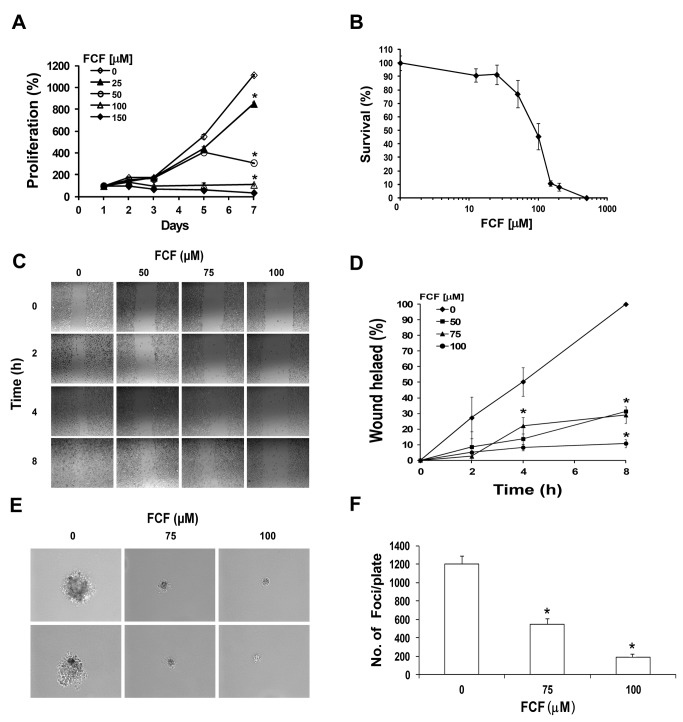
FCF inhibits cell proliferation, migration and transformation.(A) PC-3 cells were treated with increasing concentrations of FCF and grown under normoxic conditions. Cells were analyzed for proliferation at the indicated times using XTT assay. Proliferation was expressed as increase in percentage of the initial absorbance that was measured 24 h after seeding (100%). Growth media and treatment were changed every other day. Points, mean (n=3 replicates); bars, SD; *P < 0.001. This is a representative experiment out of 3 independent repetitions. (B) PC-3 cells were treated with FCF and grown under normoxic conditions for 72 h and processed for SRB cytotoxicity assay. Cell survival was expressed as percentage of the initial absorbance measured in vehicle (0.08% DMSO) control cells (100%). Points, means (n=3); bars, SD. (C) PC-3 cells were grown in 6-well plates to reach 90% confluence. They were then treated with FCF and grown under normoxic conditions for 16 h. The cell monolayer was scratched using a sterile 200-μl pipette tip, and the wounded cultures were watched and photographed after 0, 2, 4 and 8 h (magnification x10). (D) Wound healing was calculated as percentage of the wound area in vehicle-treated cells at 8 h (100%). Points, mean (n = 3); bars, SD. *P < 0.01. (E) PC-3 cells were grown on soft agar and treated with 0, 75 or 100 µM FCF, under normoxic conditions for 3 weeks. A representative colony from each FCF treatment is shown (Magnification x20). (F) A quantitative analysis of colonies for each treatment. Columns, means (n=2); bars, SD. *P < 0.01.